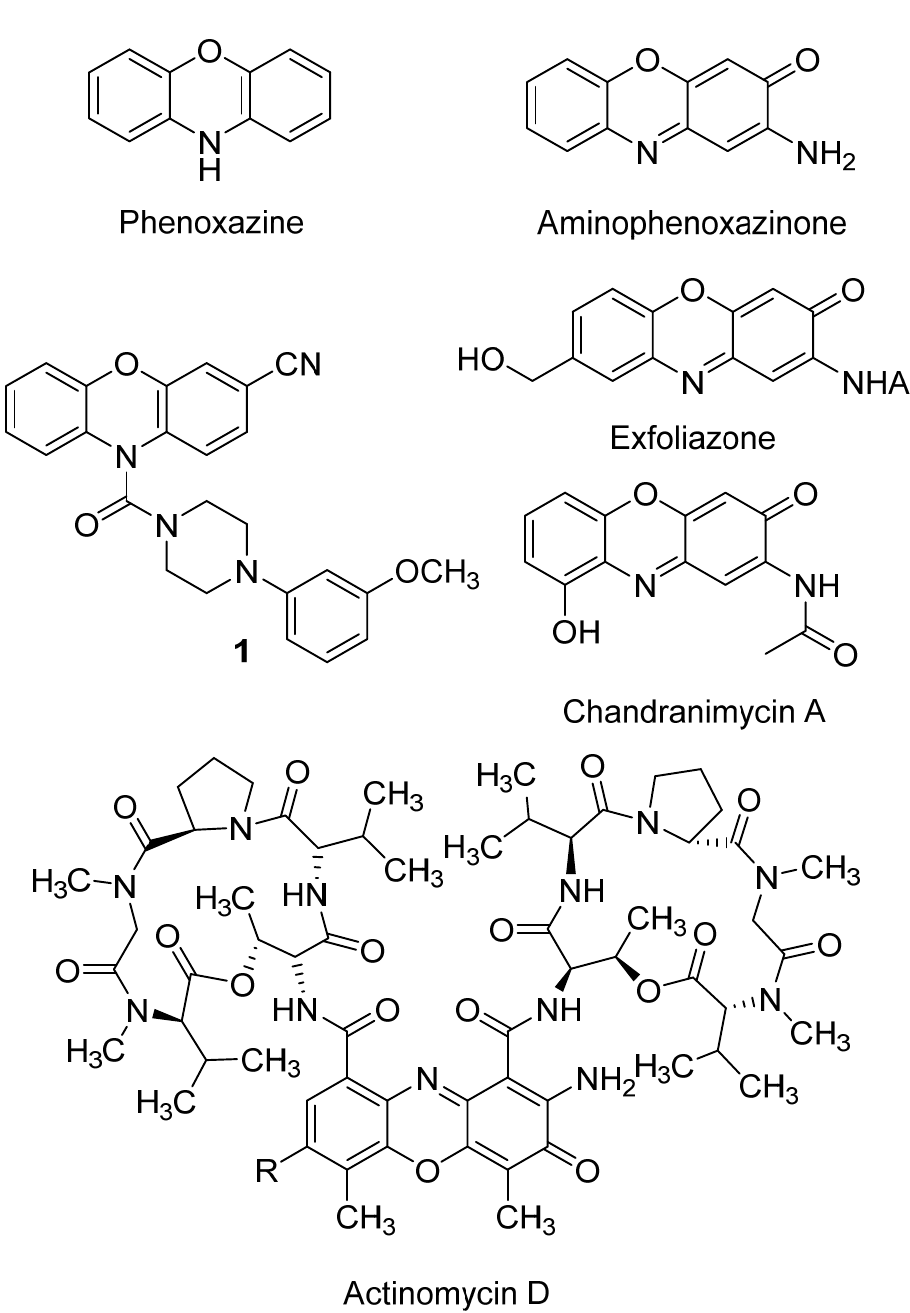
Figure 2. Phenoxazine and aminophenoxazinone structures, and some molecules of their different derivatives, like the drug actinomycin D.